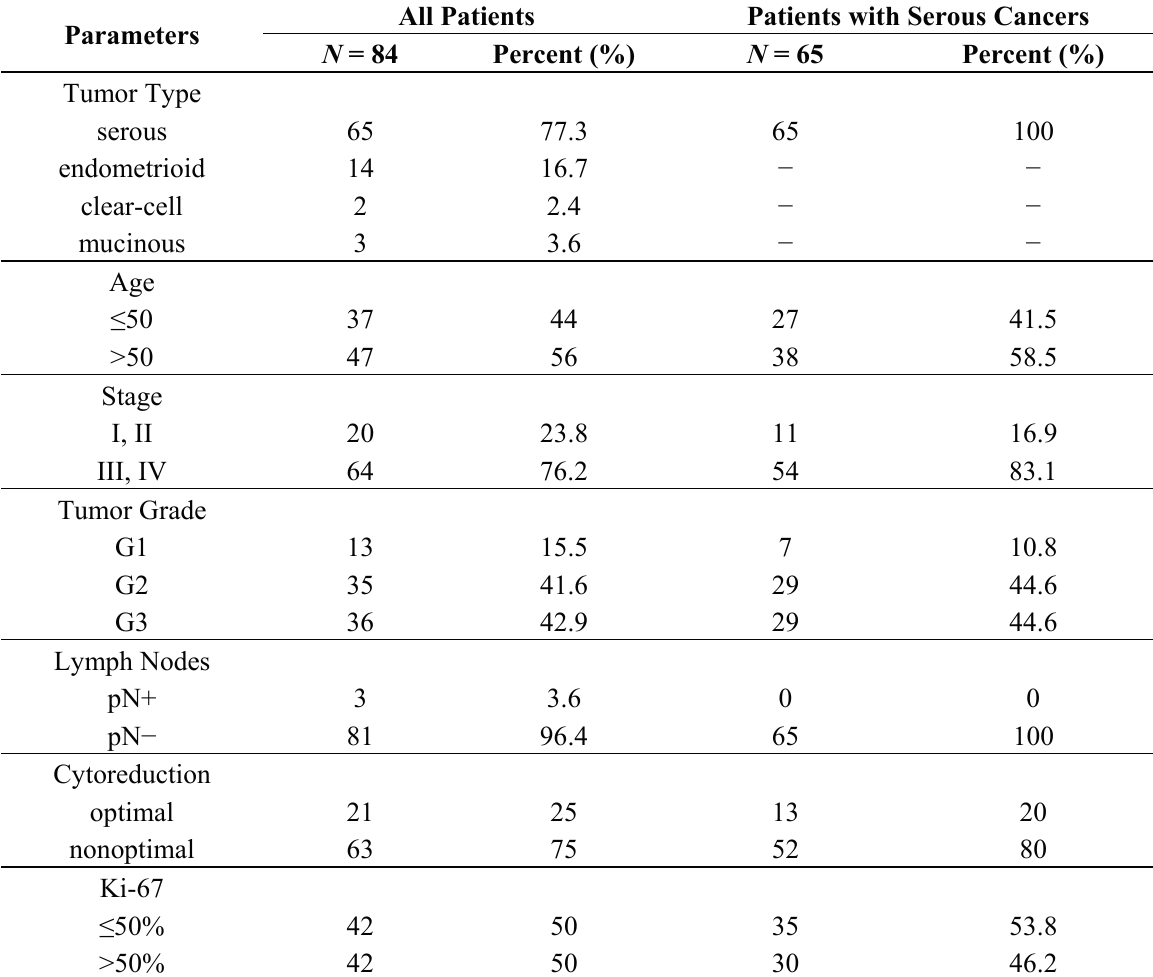
Table 2. Clinical and pathological characteristics of 84 studied